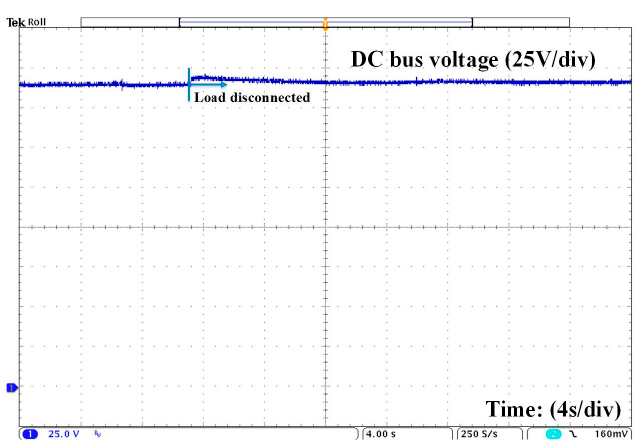
Figure 19. Connection of 300 W fluorescent lamps. Energies 2020 , 13 , x FOR PEER REVIEW